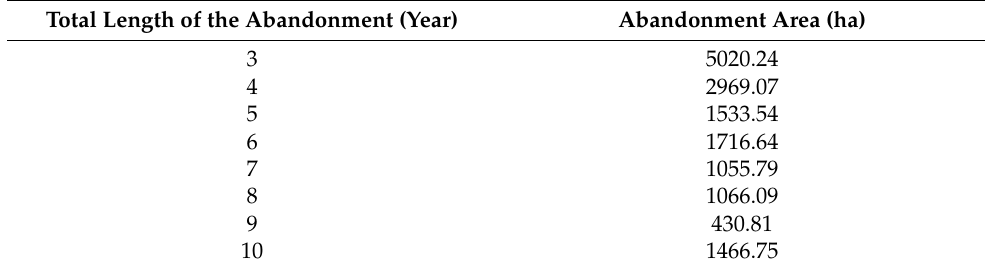
Table 4. Abandoned areas of different total length of abandonment in Gaolan County.